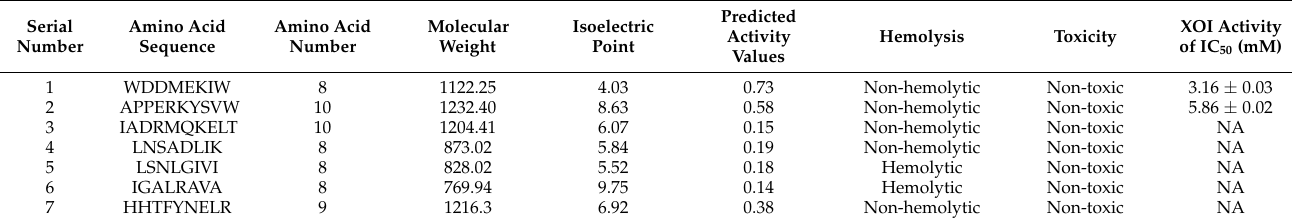
Table 3. Prediction of physicochemical properties of active